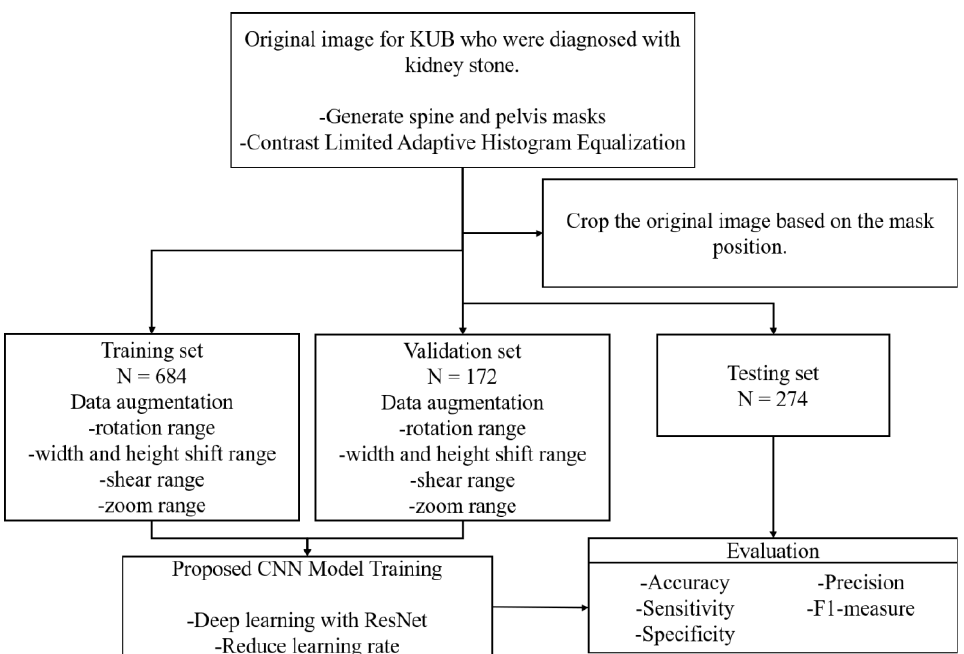
Figure 1. Process flow used in this